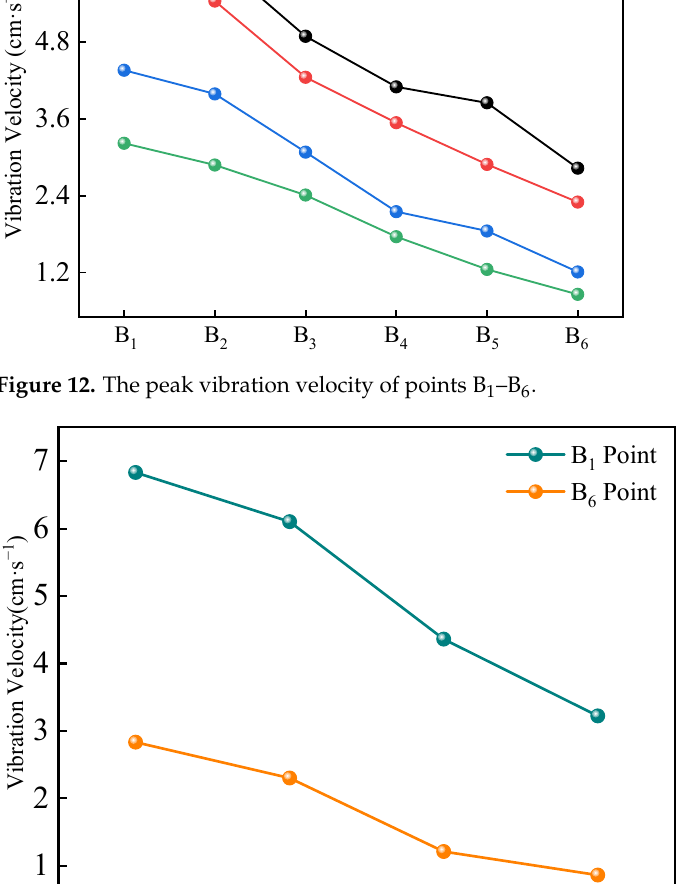
Figure 13. The peak vibration velocity decay rate of points B 1 and B 6.